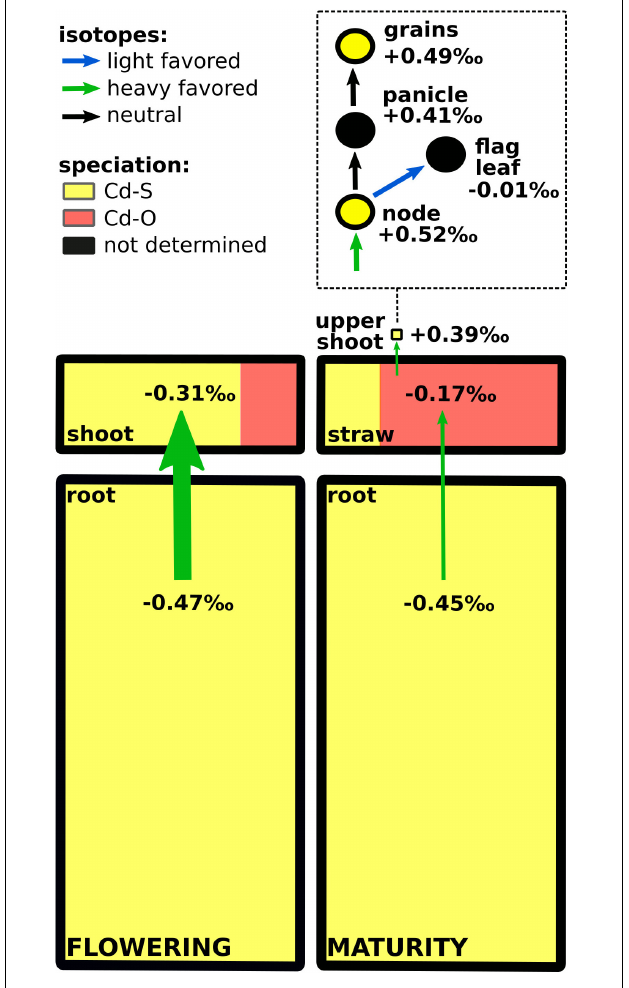
FIGURE 7 | Summary of Cd isotope fractionation and Cd storage forms in rice that grew on a Cd contaminated soil in upland conditions. Boxes (flowering left and maturity right) are proportional to the mass of Cd in each compartment (root, shoot, straw, and upper shoot), while circles are not proportional to the Cd mass (node, flag leaf, panicle, and grain). Isotope values are given as δ 114 / 110 Cd. Cd-O denotes Cd bound to COOH/OH groups and Cd-S represents Cd bound to thiols (R-SH). In the roots, Cd was fully bound to S despite plant senescence during the grain filling period. In the shoots, Cd was bound to S and O and changed during grain filling. Both, Cd-O and Cd-S storage forms may contribute to the retention of Cd in roots and shoots since only a minor fraction of Cd accumulated in the upper shoot and ultimately in the grains. The grains were strongly enriched in heavy isotopes, which is likely induced through strong chelation of Cd by thiols and by membrane transport. Isotope fractionation and Cd speciation in the upper shoot suggest that heavy Cd isotopes are favorably transported from xylem to phloem and Cd-S may persist during the transport from nodes via panicle into the